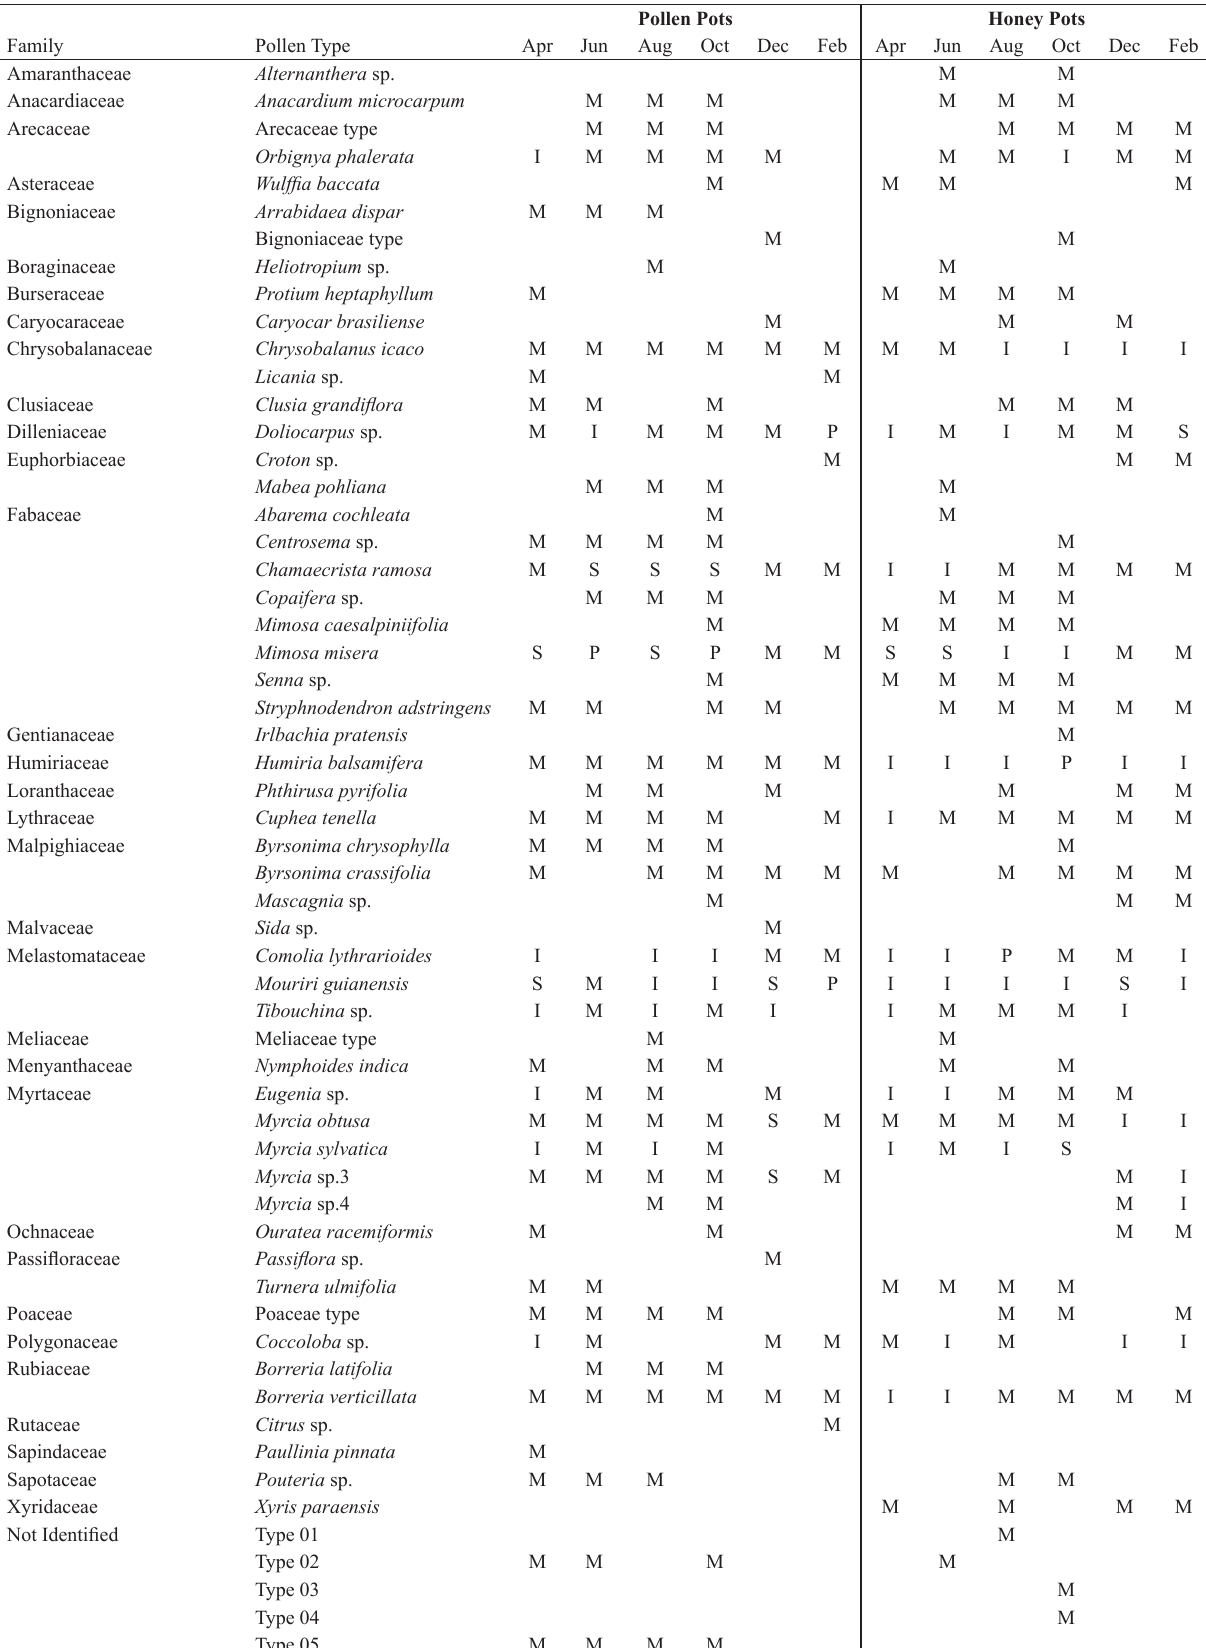
Table 1 . Occurrences and frequencies of pollen types in pollen and honey pots of Melipona subnitida in a restinga area, Maranhão state, Brazil. Classification: P – Predominant Pollen (more than 45% of the grains counted), S – Secondary Pollen (15 to 45%), I – Important Minor Pollen (3 to 15%) and M – Minor Pollen (less than 3%). Apr (April), Jun (June), Aug (August), Oct (October), Dec (December), Feb